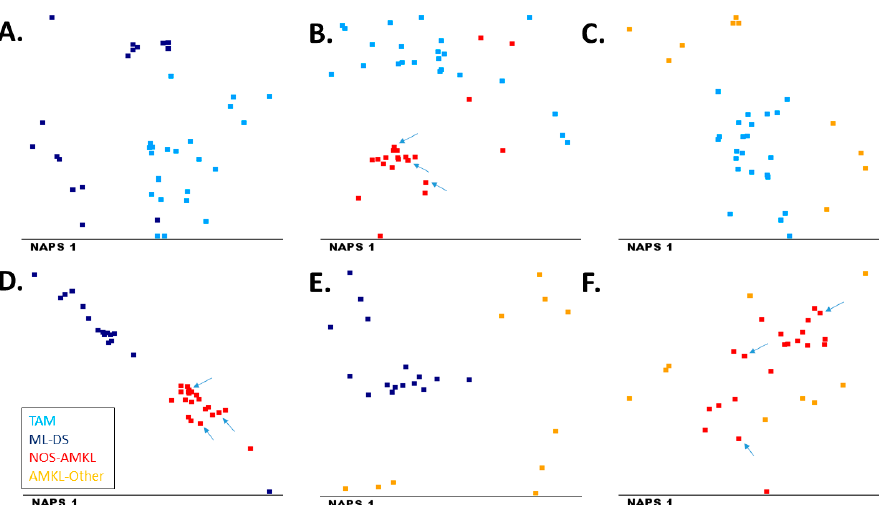
Figure 6. Multivariate analysis of marker expression between the four AMKL subgroups. ( A ) TAM versus ML ‐ DS (contributing markers: CD7 (47%), CD11b (31%) and CD13 (21%)); ( B ) TAM versus NOS ‐ AMKL (contributing markers: CD117 (28%), CD4 (21%) and CD42b (19%)); ( C ) TAM versus AMKL ‐ Other (contributing markers: CD117 (61%), CD13 (36%) and CD19 (3%)); ( D ) ML ‐ DS versus NOS ‐ AMKL (contributing markers: CD7 (68%), CD117 (27%) and CD11b (3%)); ( E ) ML ‐ DS versus AMKL ‐ Other (contributing markers: CD33 (51%), CD203c (28%) and CD38 (21%)); ( F ) NOS ‐ AMKL versus AMKL ‐ Other (contributing markers: CD7 (97%), CD38 (2%) nad CD117 (0.4%)). The arrows indicate NOS ‐ AMKL patients with t(1;22).